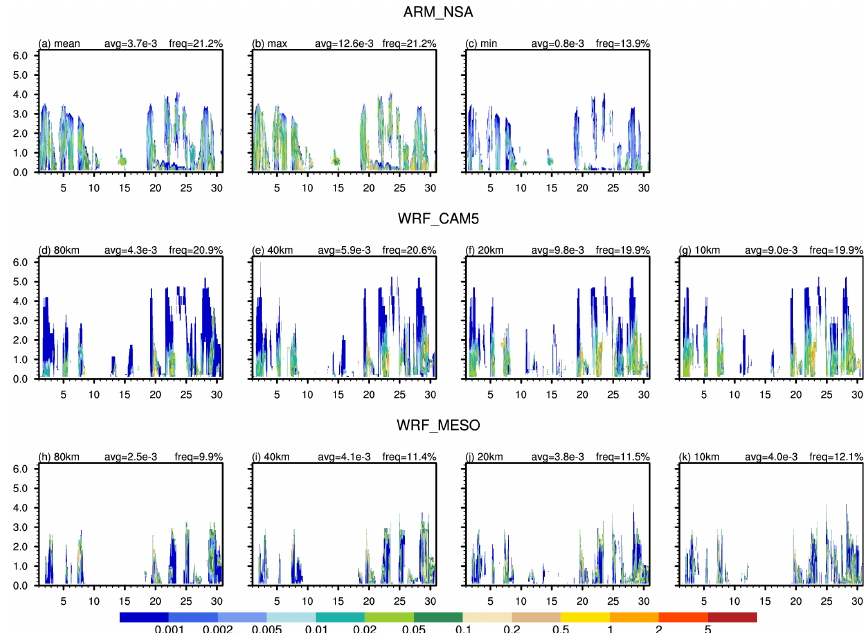
Fig. 15. Time series of vertical profiles of liquid water content (gkg − 1 ) from ARM: (a) hourly mean, (b) hourly maximum, and (c) hourly minimum, compared with the in-cloud liquid water content (gkg − 1 ) from (d) – (g) WRF_CAM5 and (h) – (k) WRF_MESO simulations at Barrow. Values of average liquid water content and frequency of occurrence of liquid cloud are given.